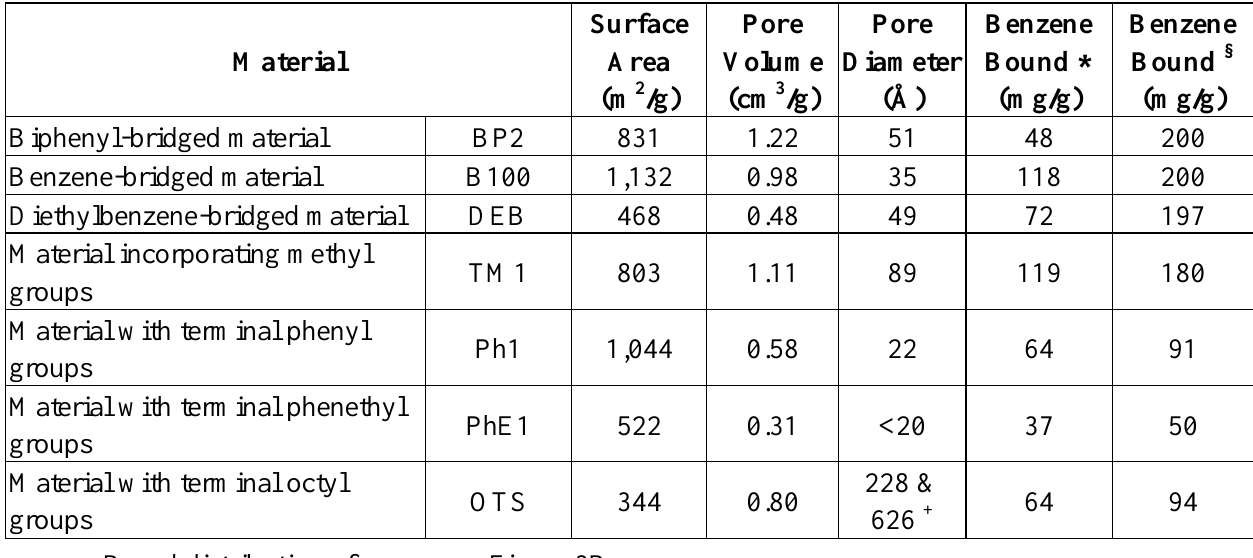
Table 1. Material